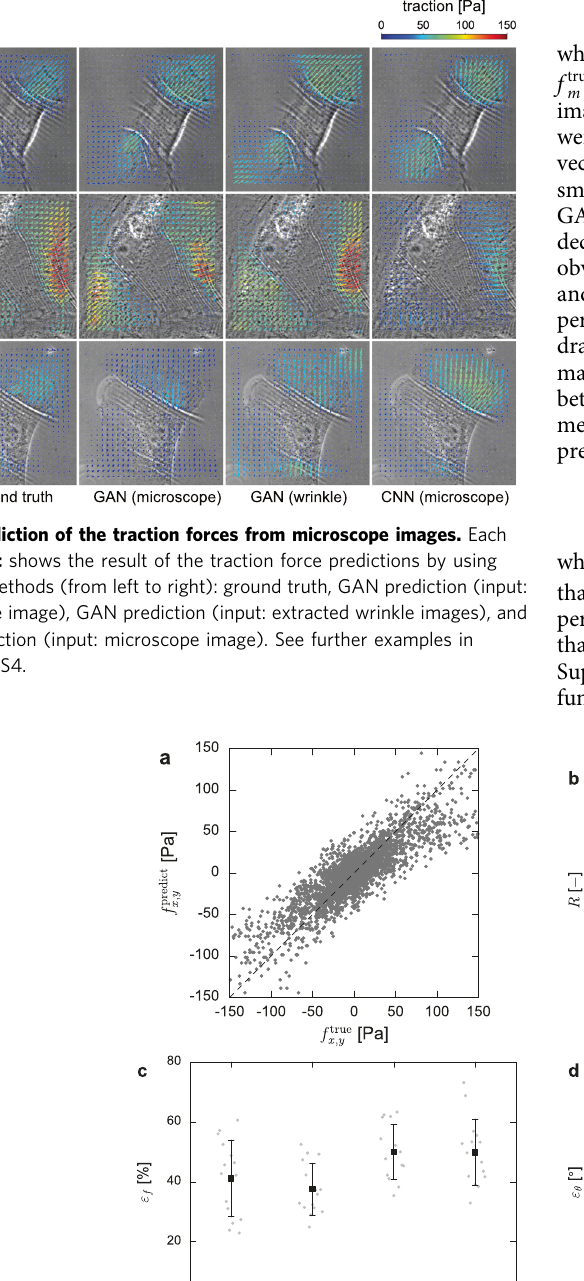
f predict x ; y and x ; y . c , d Errors of